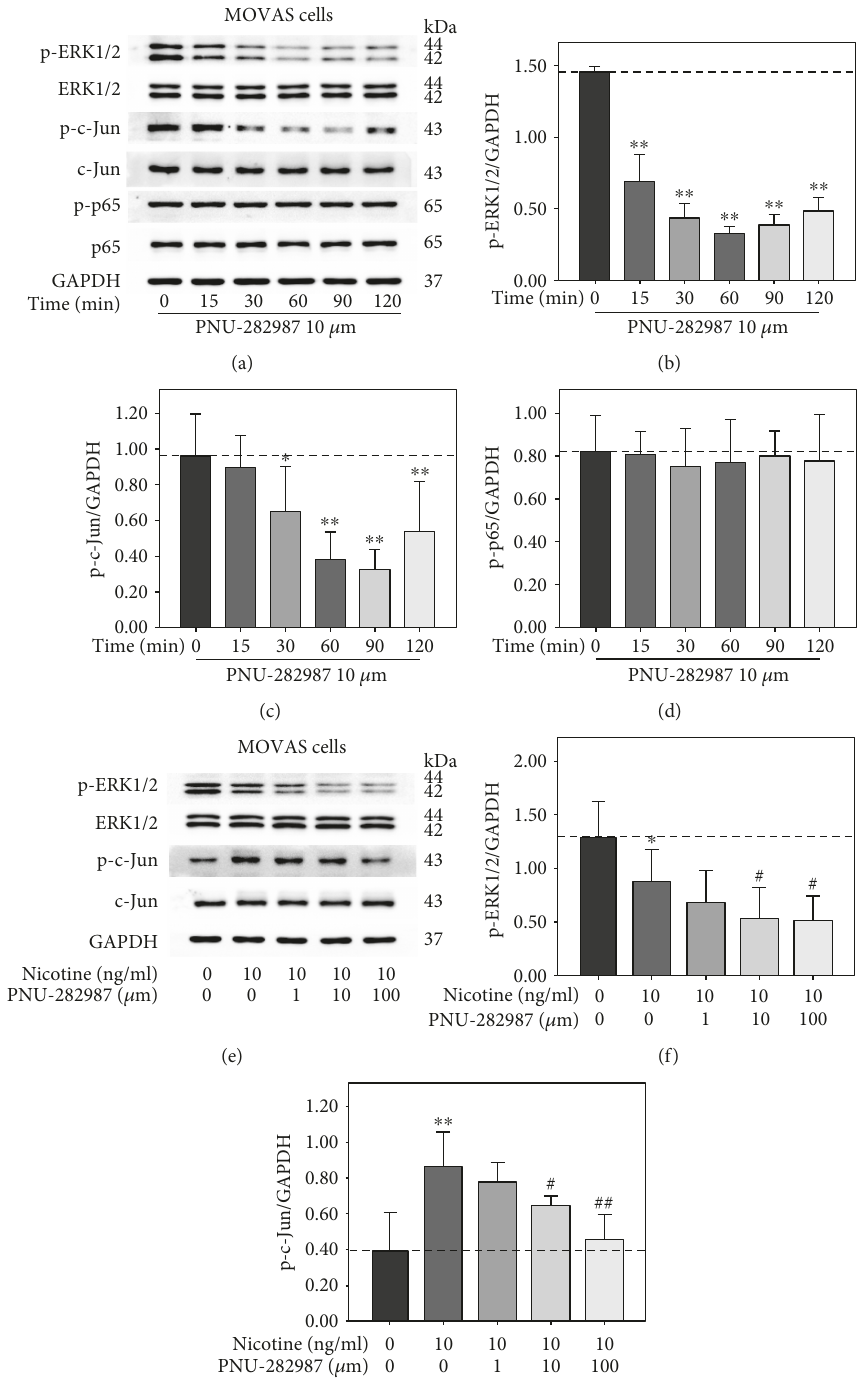
Figure 6: PNU-282987 inhibited nicotine-stimulated activation of c-Jun in MOVAS cells. (a) MOVAS cells were exposed to 10 μ m PNU- 282987 for 0, 15, 30, 60, 90, and 120min. (e) MOVAS cells were pretreated with 10 μ m PNU-282987 for 60 min prior to 10 ng/ml nicotine exposure for 30 min. Cell lysates were collected, and protein levels of phosphorylated extracellular signal-regulated kinase1/2 (p- ERK1/2), ERK1/2, p-c-Jun, c-Jun, p-p65, and p65 were measured by Western blot. (b – d, f, g) Densitometric analysis of protein bands was performed via ImageJ software, with all experiments being analyzed as three di ff erent independent experiments and GAPDH used as an internal control. ∗ p < 0 05 and ∗∗ p < 0 01 versus controls; # p < 0 05 and ## p < 0 01 versus the group treated with